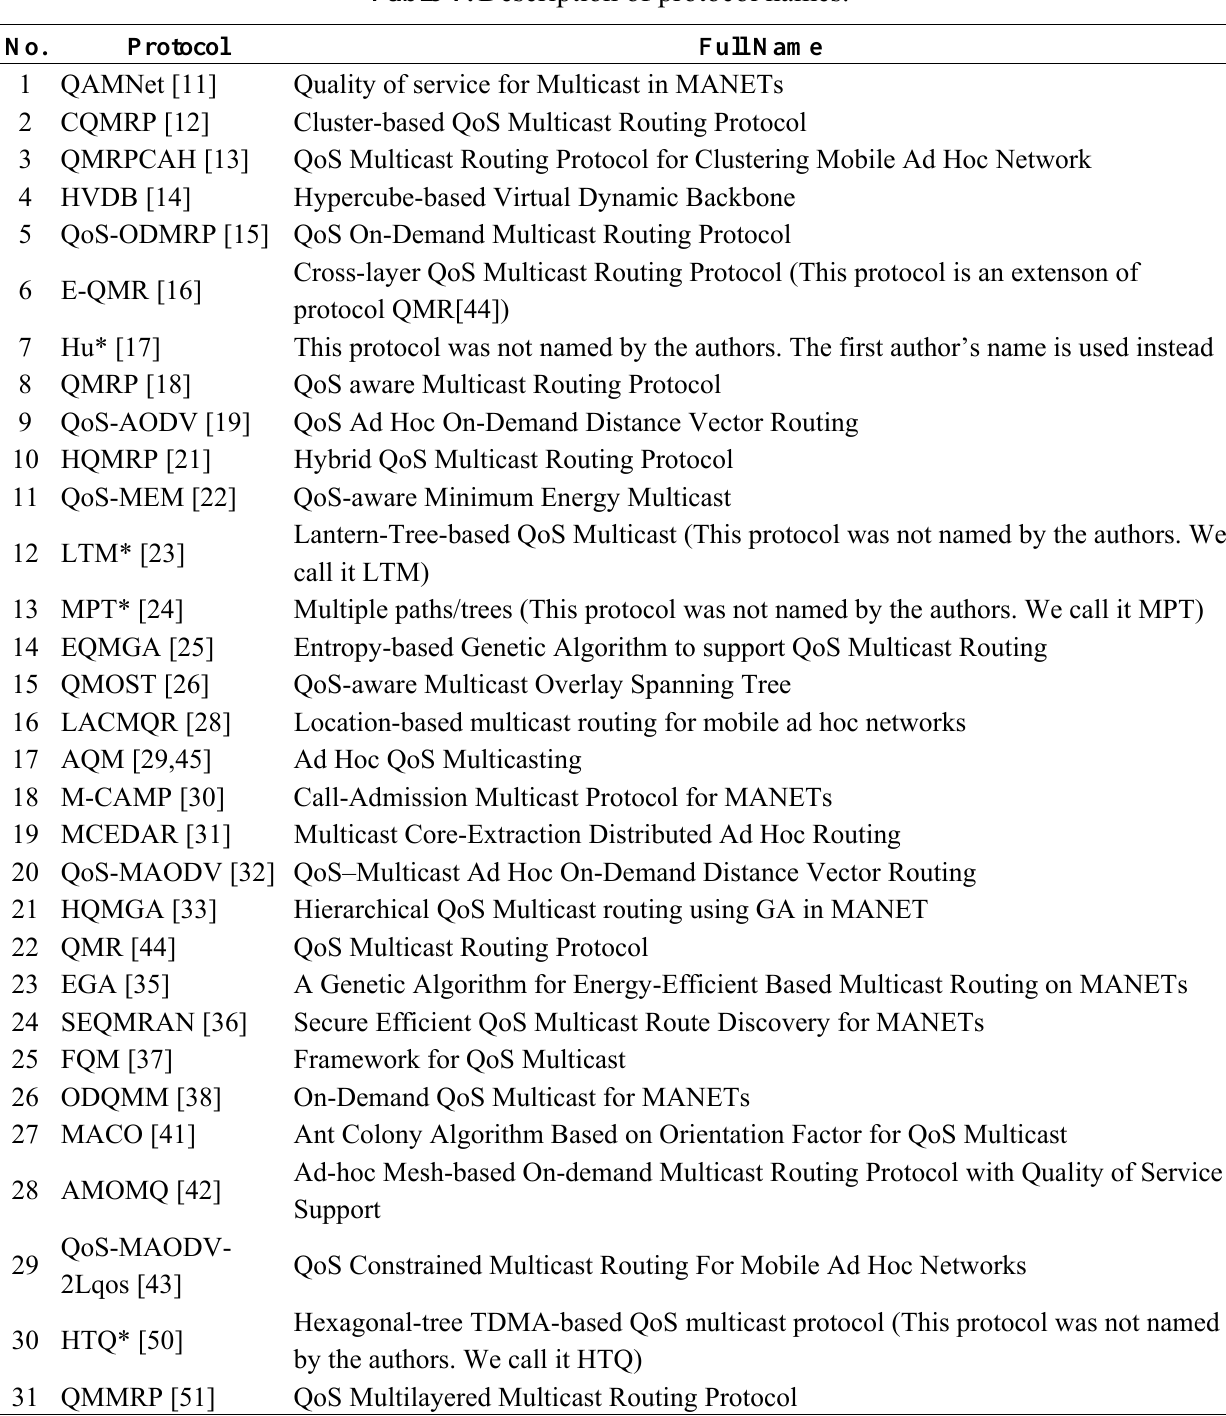
Table 1. Description of protocol